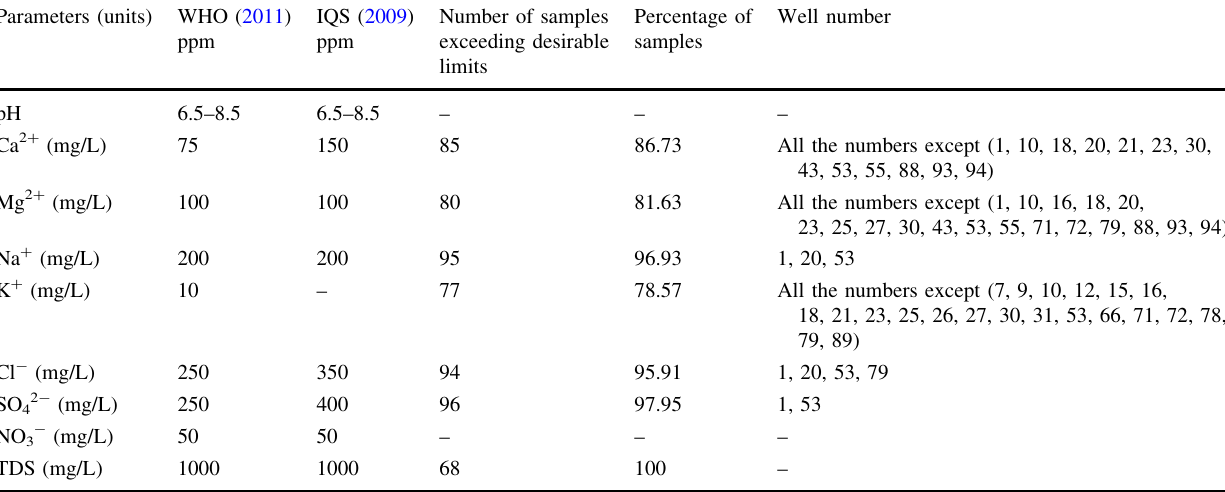
Table 6 The hydrochemical parameters of the study area in comparison with WHO (2011) and IQS 2009 drinking water Standards Parameters